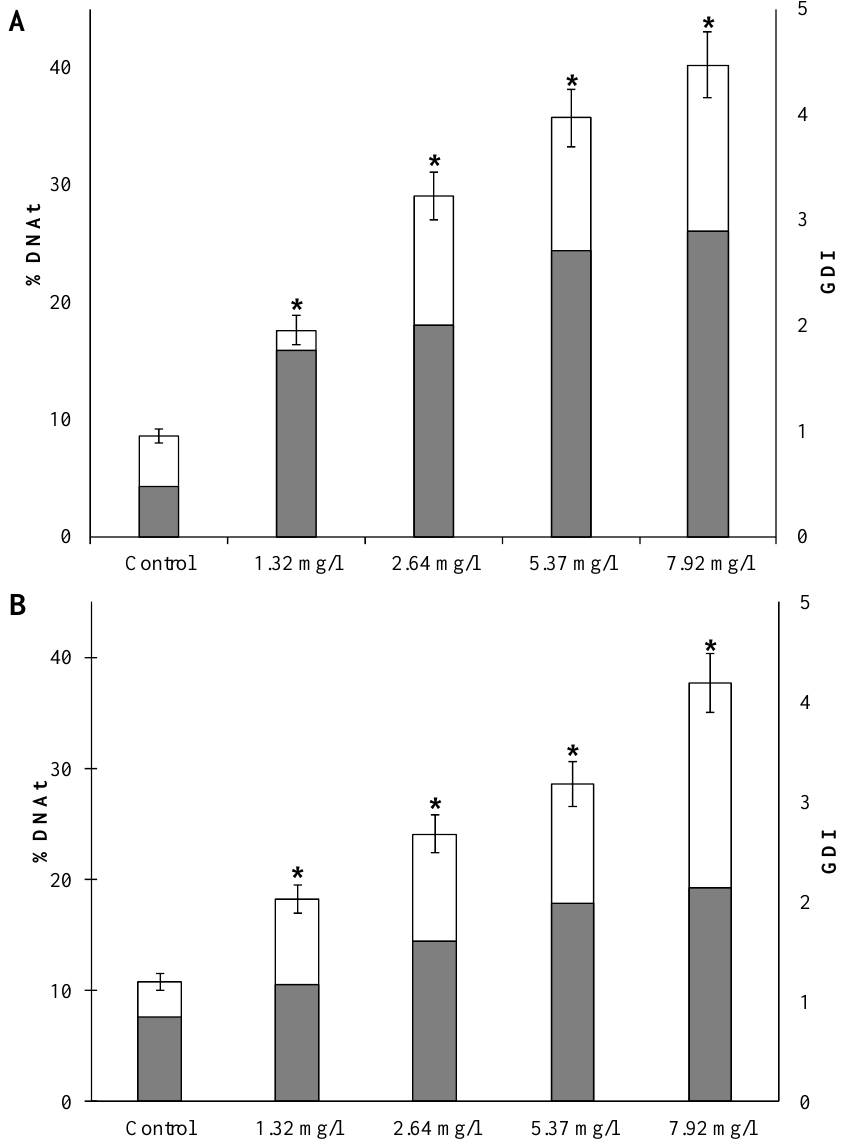
Figure 1. Level of DNA damage in sperm ( A ) and eggs ( B ) of sand dollar S. mirabilis after exposure to different concentrations of WAF-DF (mean ± standard deviation). * Difference from the control is significant ( p < 0.05).